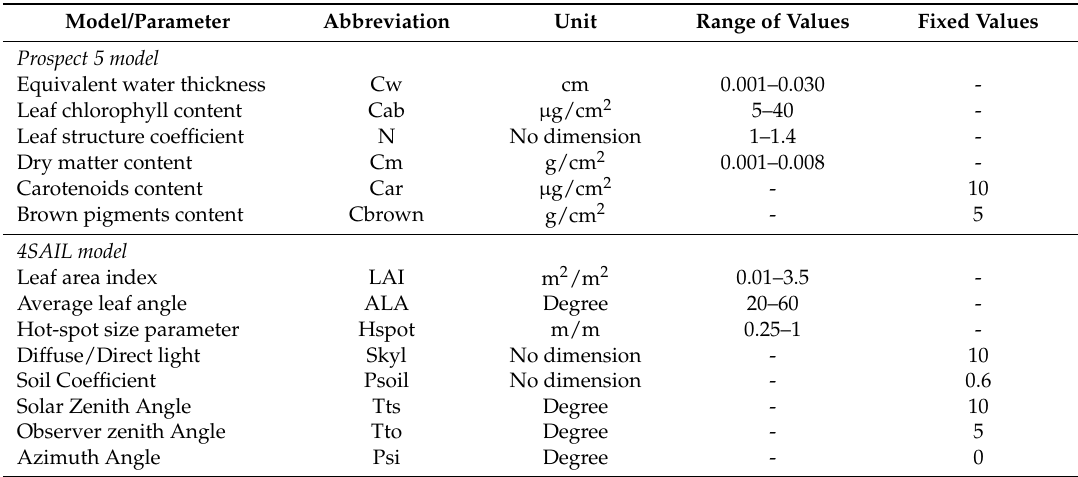
Table 5. Input parameters of PROSAIL used to generate LUT for maize in the study